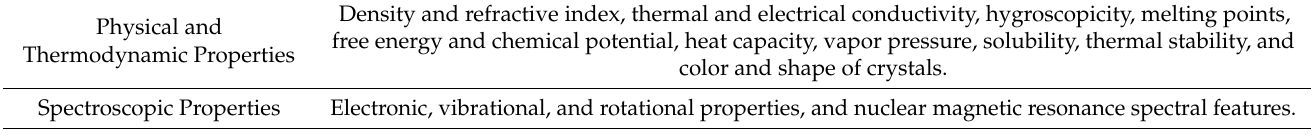
Table 1. Physico-chemical properties that may depend on the crystal